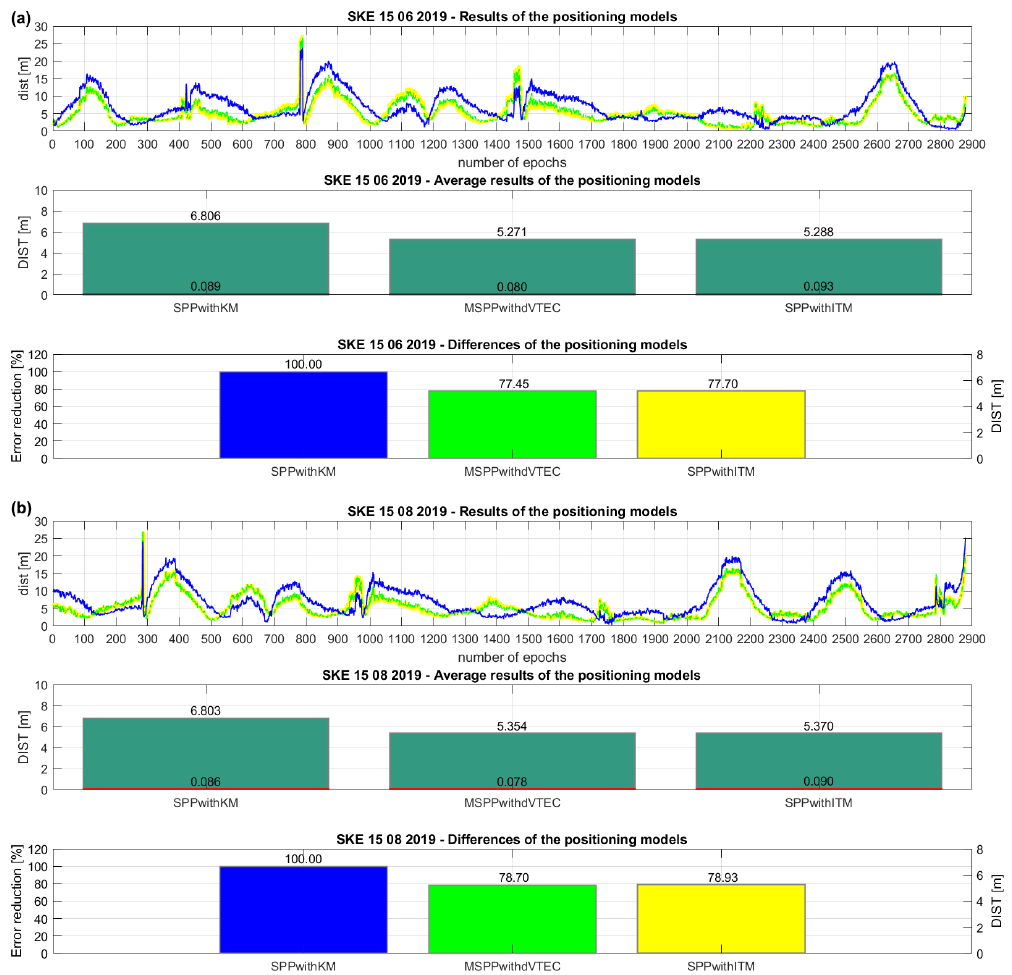
Figure 2. Set of the results of the positioning models: (a) SKE 15 June 2019 and (b) SKE 15 August 2019.